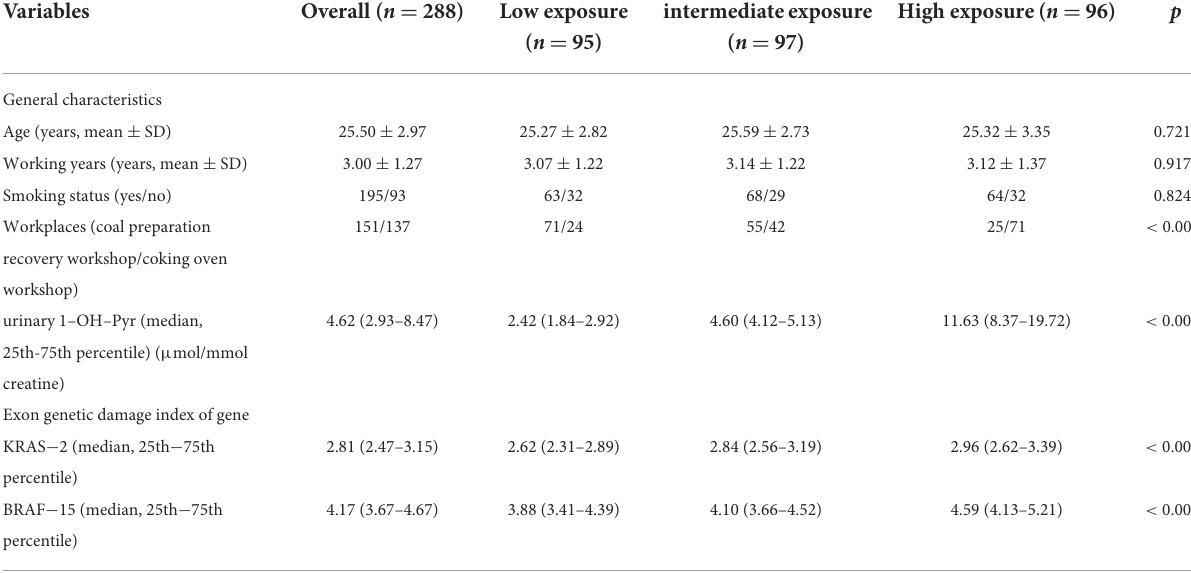
TABLE 1 General characteristics of study participants and exon genetic damage index stratified by tertiles of urinary 1-OH-Pyr